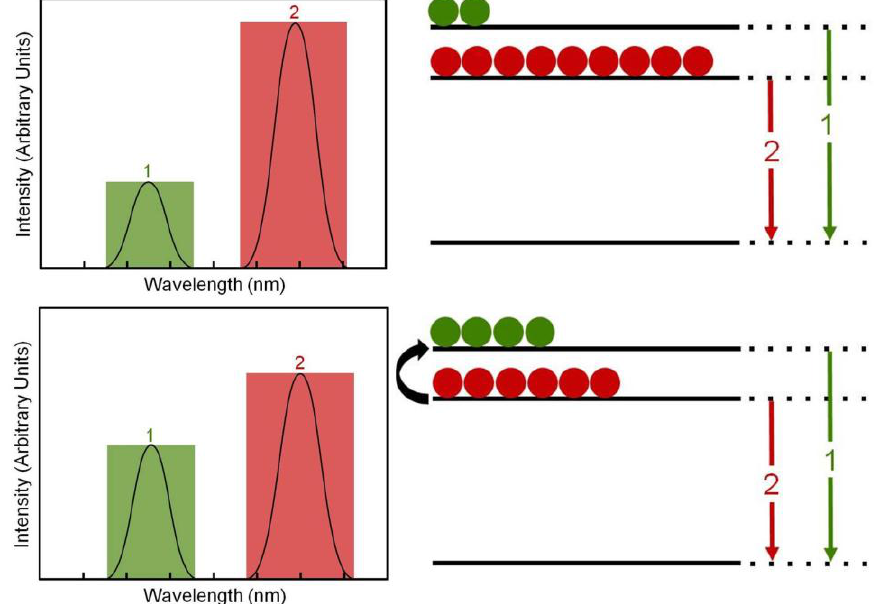
Figure 22. Temperature estimation mechanism based on Ln 3+ doped